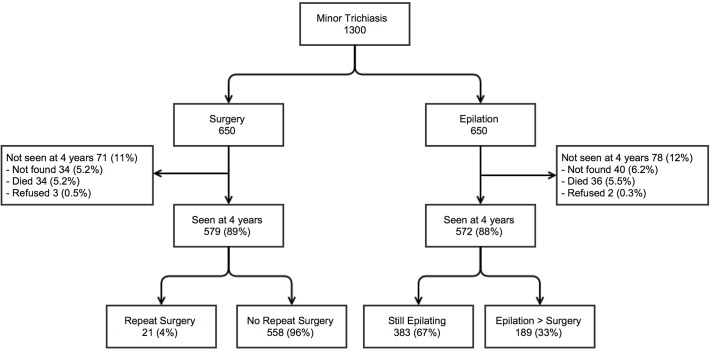
Study participant flow diagram.